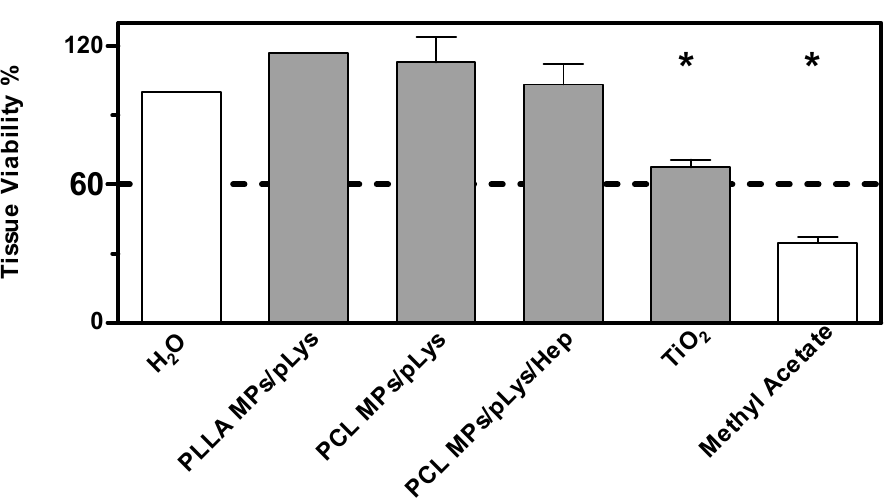
Figure 7. Eye irritation potential of polyester particles at the concentration of 0.5% by the EpiOcular test. Mean ± SD, n = 3. * p ≤ 0.05, ANOVA with post hoc Bonferroni